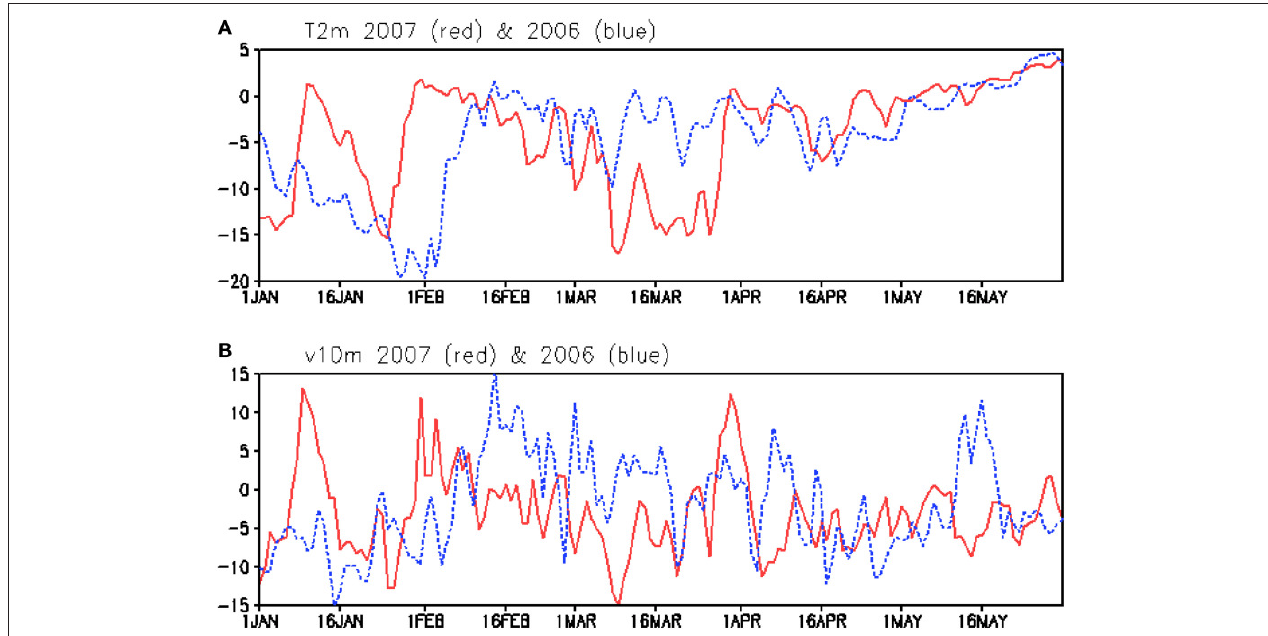
FIGURE 10 | Area-mean surface (2 m) air temperature ( ◦ C) (A) and surface (10 m) meridional wind (B) averaged over the region of 56–62 ◦ N and 180–160 ◦ W in 2007 (red) and 2006 (blue).